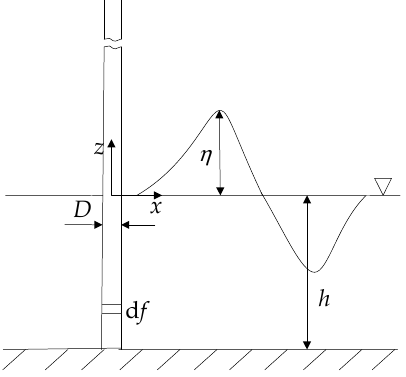
Figure 2. Simple schematic diagram of regular wave.